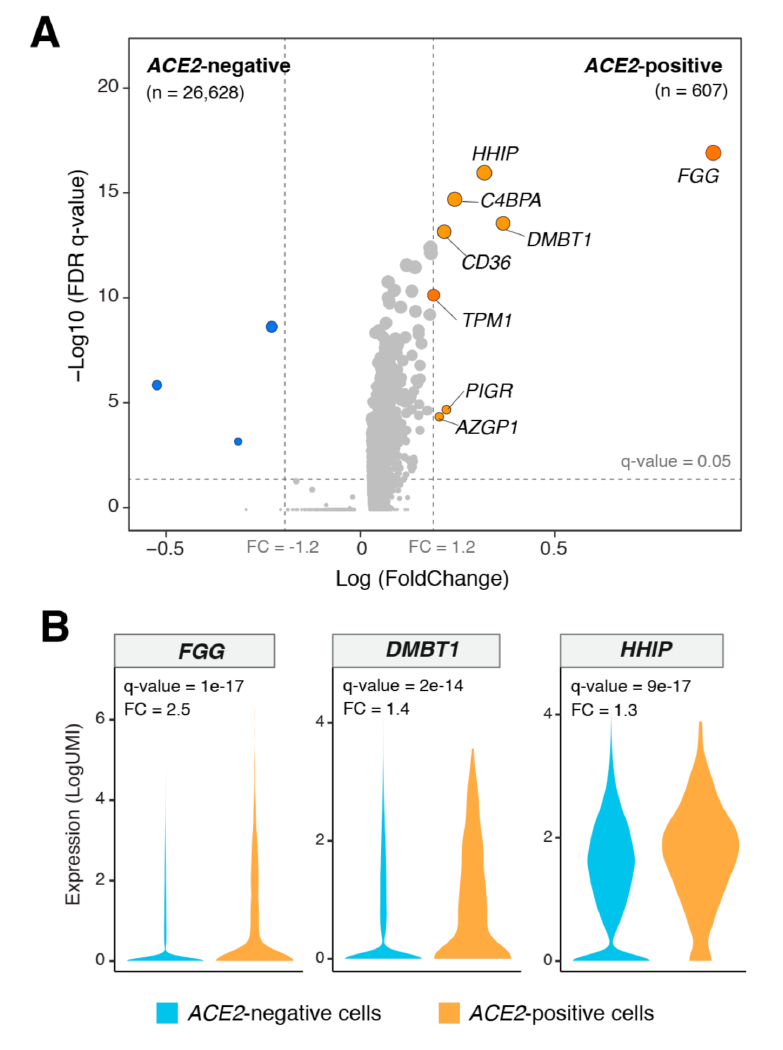
Figure 3. Differentially expressed genes between ACE 2-positive and -negative AT2 cells. ( A ) Volcano plot showing significantly differentially expressed genes (DEGs) between ACE2-positive ( n = 607) and -negative ( n = 26,628) AT2 cells. A cutoff of absolute gene expression (fold-change: >1.2) and a FDR ( q -value < 0.05) were applied to identify the DEGs. Blue indicates downregulation, and orange indicates upregulation. ( B ) Violin plots showing the significant upregulation of FGG, DMBT1, and HHIP genes in ACE2 -positive compared with -negative AT2 cells. FC: Fold